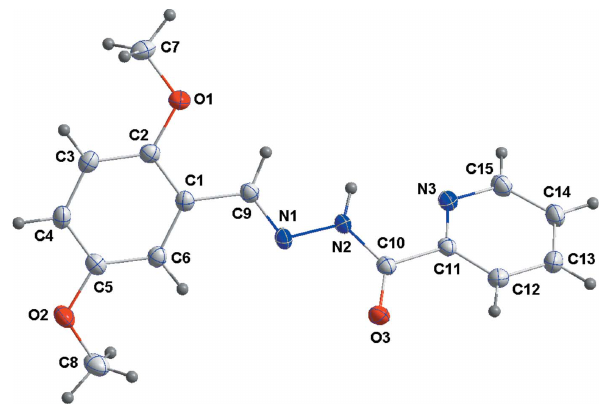
Figure 1 The title molecule of the title compound, with the atom-labelling scheme and 50% probability displacement